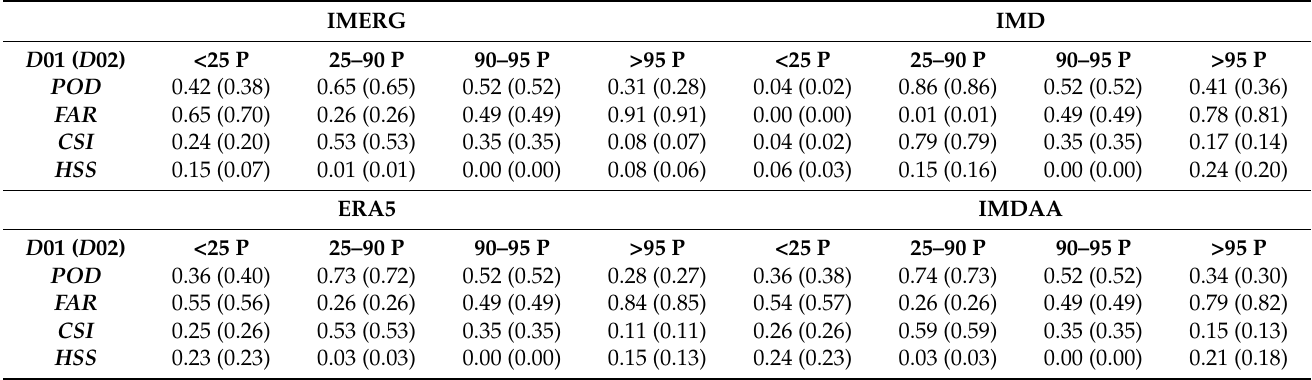
Table 3. Categorical statistics for the examination of the model’s ability to detect (area averaged) low, moderate, heavy, and extreme precipitation events during DJF months against that of IMERG, IMD, ERA5 and IMDAA. IMERG